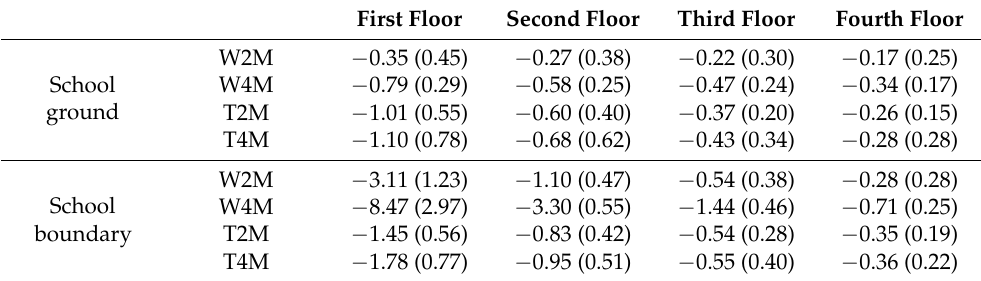
Table 5. Change rate of PM 2.5 concentration by the school building floor for each case compared to the CNTL case (%). The parentheses indicate the standard deviations of the PM 2.5 concentration calculated for 16 inflow directions. First Floor Second Floor Third Floor Fourth